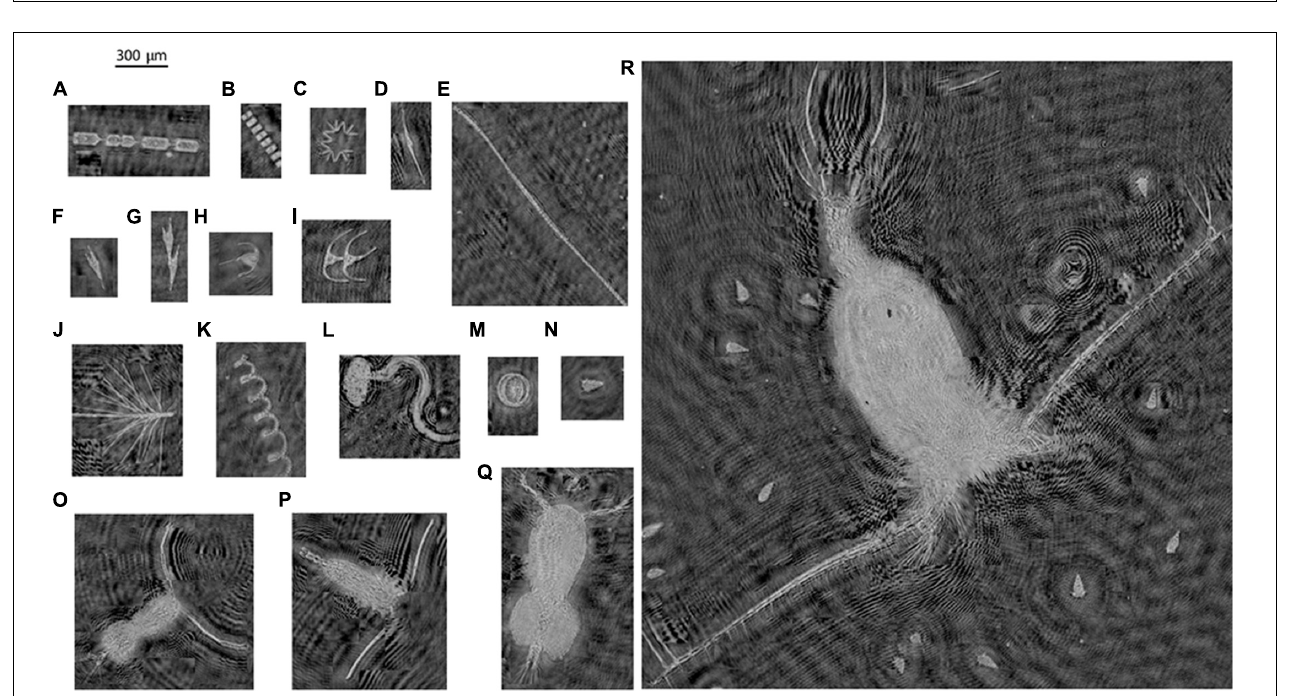
FIGURE 2 | An illustrative example showing the different steps in holographic data processing: (A) A sample raw unprocessed hologram; (B) The same image after background subtraction, with regions of interest highlighted, and showing only interference patterns; (C) The in-focus diatom chains at different reconstruction depths ( z ) within the sample volume in the highlighted region; and (D) The 2-D composite image, where all in-focus particles are collapsed onto the same plane for further analysis.